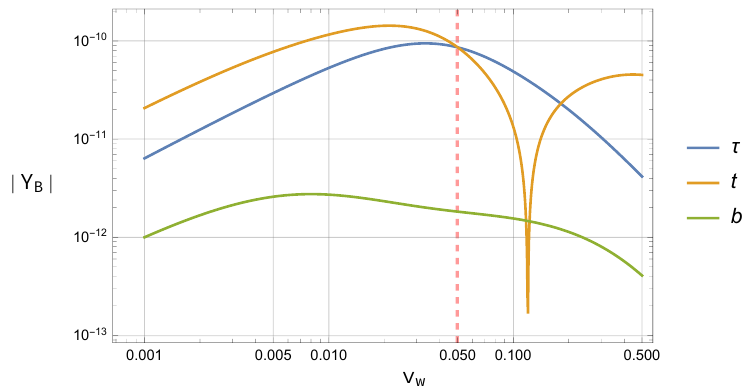
Figure 7. The baryon asymmetry (in absolute value) | Y B | as a function of the bubble wall velocity v w . Each curve represents a source term. The benchmark value v w = 0 . 05 is marked in dashed-red which is close to the optimal value of v w for the top and the tau. The sharp dip in the curve for t (orange curve) is a point where Y B changes sign. As explained in table 2 of appendix A, the values for T τ,t are chosen such that Y B = Y obs at v w = 0 . 05 , while T b is arbitrarily normalized since it B I I cannot produce the observed asymmetry.